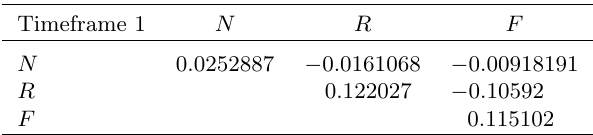
Fig. A.4. Number of countries as a function of the fraction of F . Table A.1. Covariances between different variables of timeframe 1 for renewable countries (nuclear countries included).